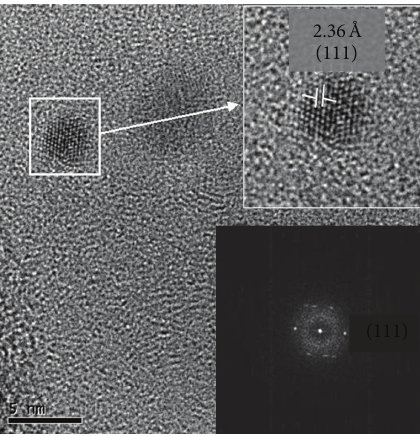
Figure 8: HRTEM image of Ag nanoparticles (top) and their corresponding Fourier transforms (FFT) (bottom) pattern.